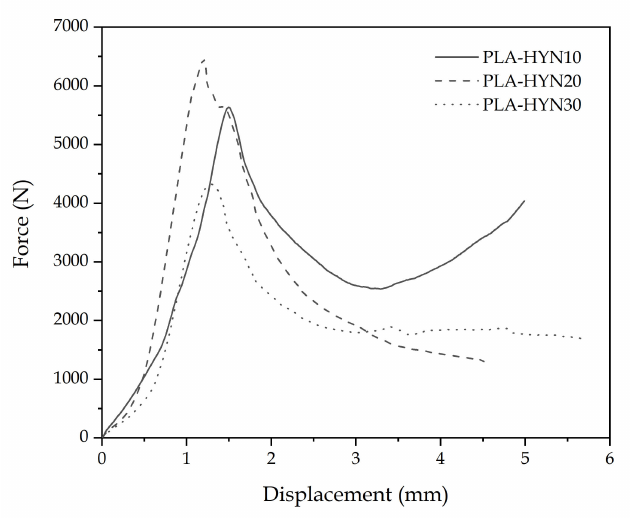
Figure 4. Characteristic force–displacement diagrams (flatwise compression test) for composite sandwiches with PLA honeycomb cores with different